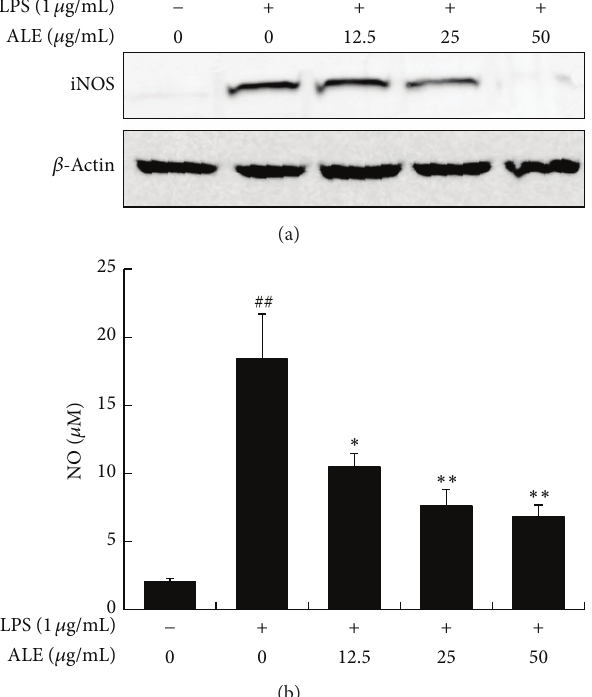
Figure 5: Effects of ALE on iNOS expression and NO production in Raw 264.7 cells. Cells were incubated with various concentrations of ALE for 4 h and then activated with 1 𝜇 g/mL of LPS for 20 h. (a) iNOS expression; (b) NO production. Values are presented as the means ± SD. ## 𝑃 < 0.01 compared to the NOR group and ∗ 𝑃 < 0.05 and ∗∗ 𝑃 < 0.01 compared to the CTL group.